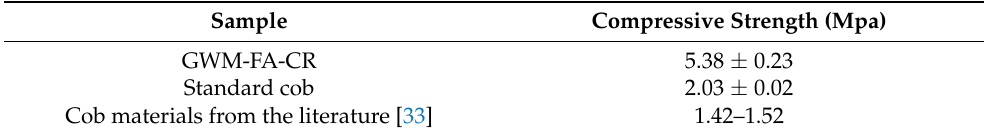
Table 7. Compressive strength of the cob and the GWM-FA-CR specimens after 3 weeks of curing compared to those of standard cob building materials from the literature.